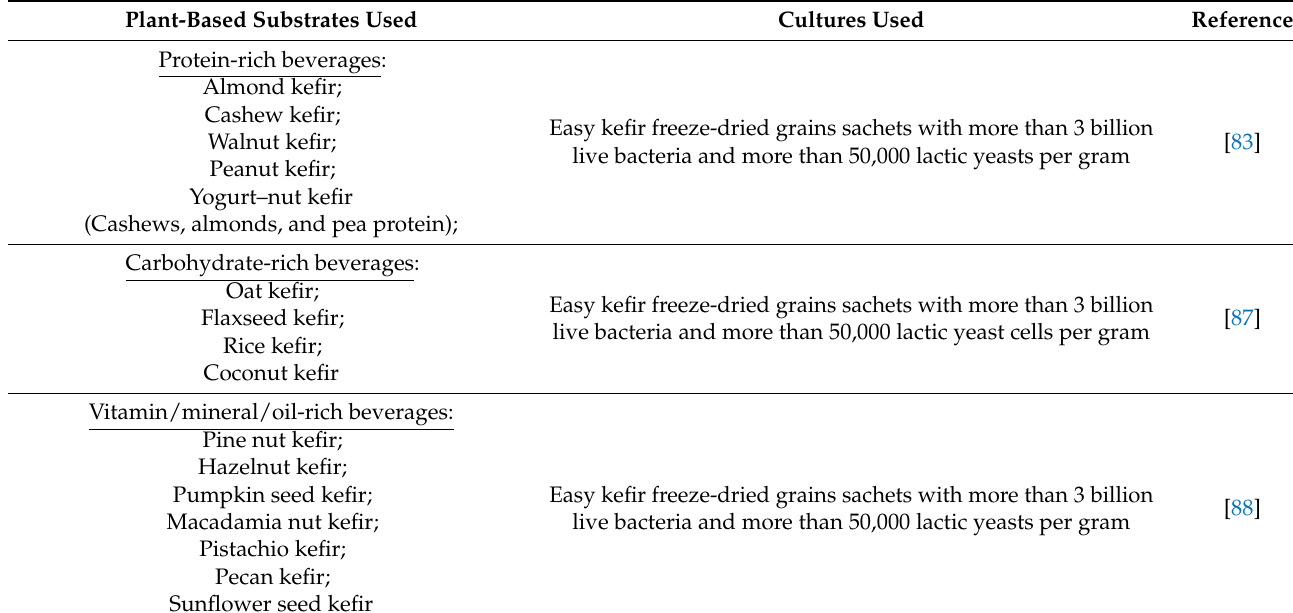
Table 2. Dairy-free probiotic kefir prepared from plant-sources for lactose-intolerant and vegans populations. Plant-Based Substrates Used Cultures Used